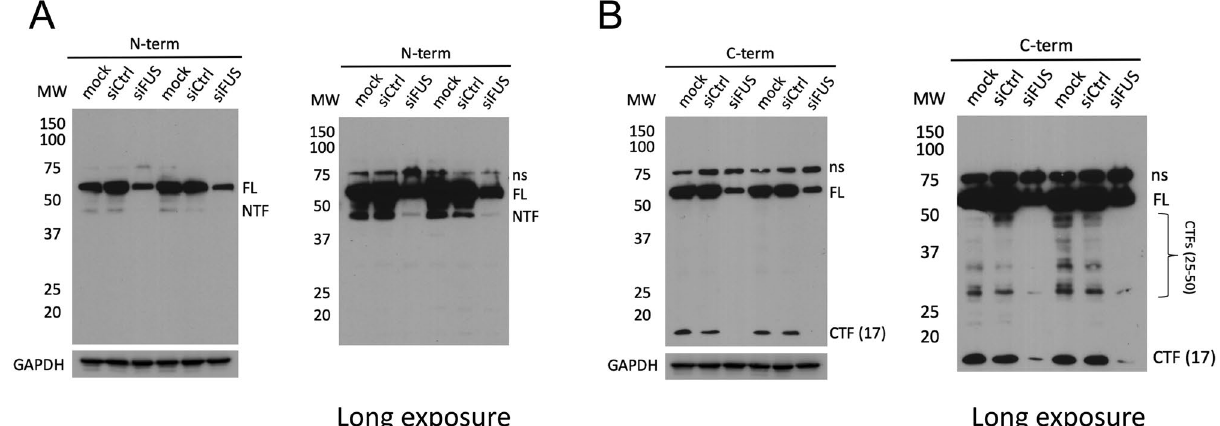
Figure 3. FUS isoforms are differentially recognized by N- and C-terminal antibodies. Western blot analysis of whole-cell lysates of U87 cells transfected with FUS siRNA. FUS immunoreactive bands were blotted with antibodies recognizing either an ( A ) N- terminal (1–50 aa) or ( B ) C-terminal (500–526 aa) epitope. FL: Full- length FUS; NTF: N-terminal fragment; CTF (17): C-terminal fragment at 17 kDa; CTFs (25–50): C-terminal fragments distributed from 25 to 50 kDa; ns: non-specific band. Uncut nitrocellulose membrane was first blotted with anti-FUS antibody and HRP-conjugated secondary antibody followed by film exposure. The same membrane was then washed with 0.1% TBST and incubated with anti-GAPDH antibody. GAPDH bands were acquired using Bio-Rad ChemiDoc MP imaging system. Original blots are shown in the Expanded file